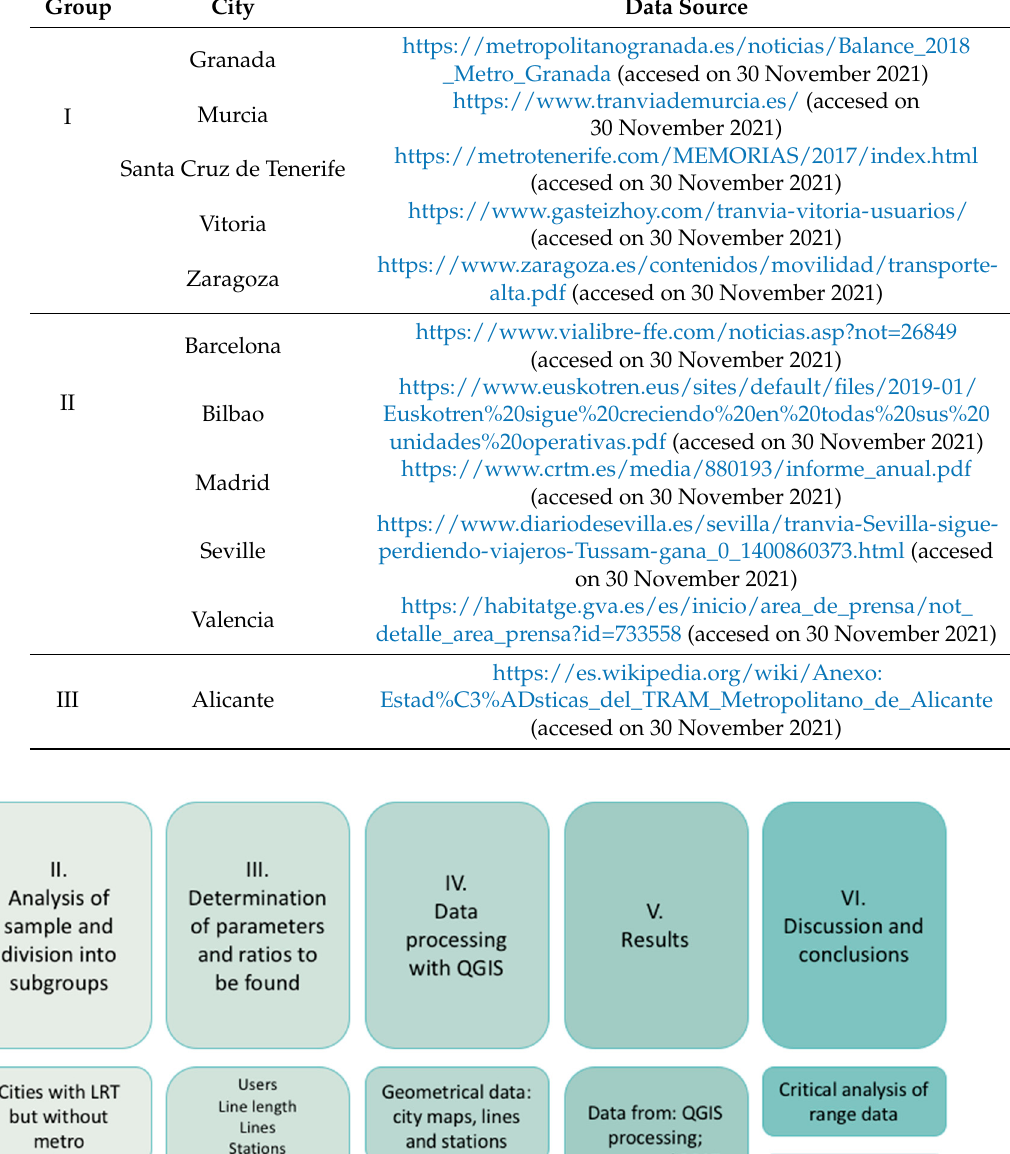
Table 2. Data sources for daily